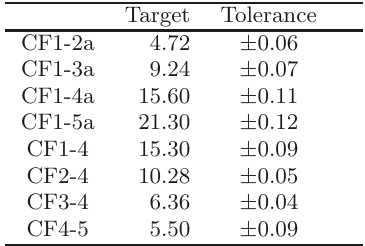
Fig. 3. Selected manufacturing dimensions for the first mea- suring step (on the top) and for the second step (at the bottom) of setup plan. Table 1. Best tolerances for the selected manufacturing dimensions.